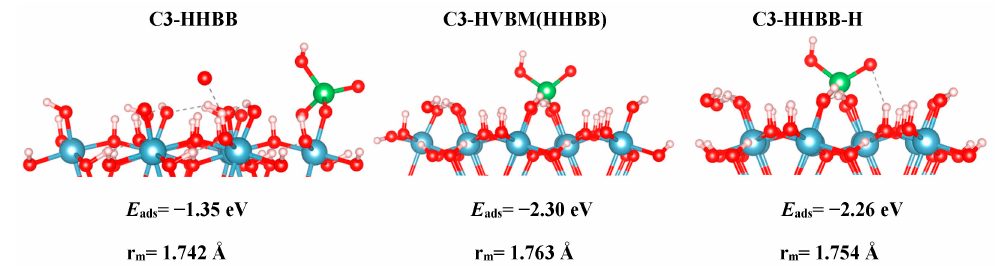
Figure 2. The A3 optimized structures. From left to right: hill–hill bidentate binuclear structure (HHBB), hill–valley bidentate binuclear structure (HVBB), and hill–valley bidentate mononuclear structure (HVBM). Aluminum, oxygen, hydrogen, and arsenic are represented by the colors blue, red, white, and green respectively. E ads and r m are the adsorption energies and averaged As–O surf distances, respectively.